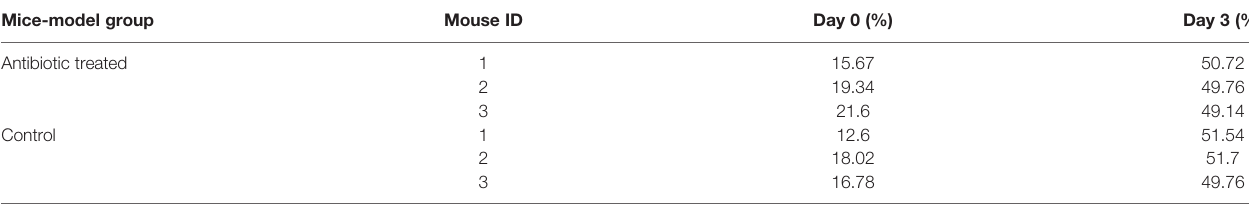
TABLE S3 | Parasitemia density of B. microti in mice at different time